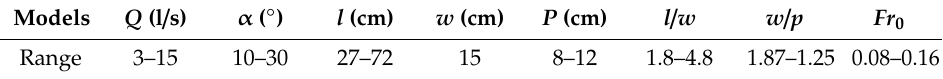
Table 1. Geometrical properties of weir models and hydraulic flow parameters in the present study.